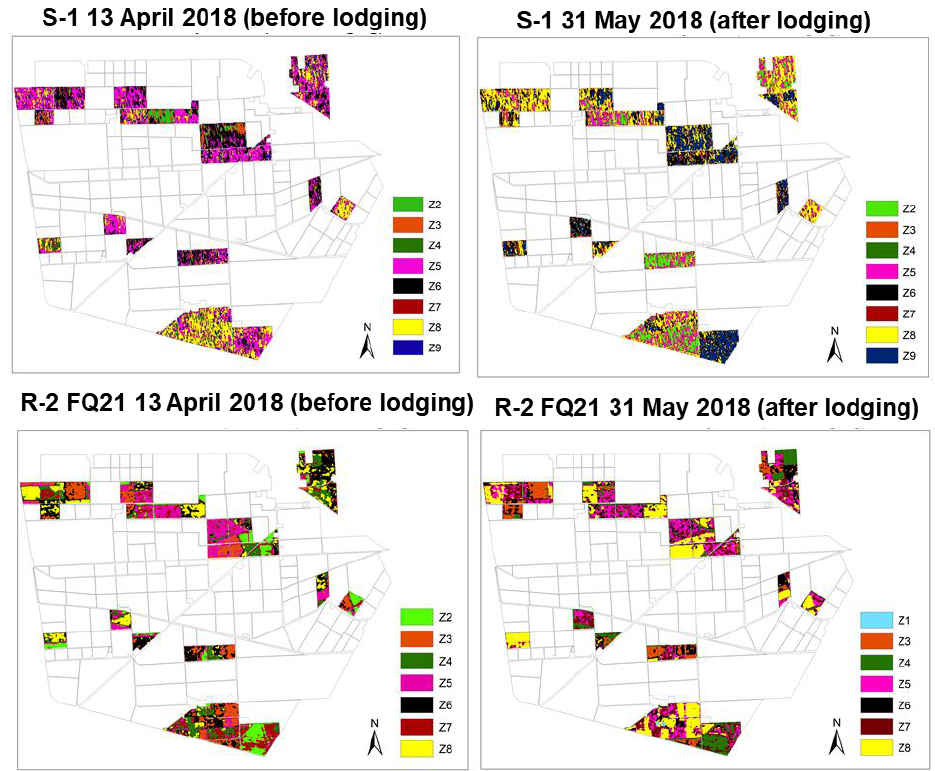
Figure 6. Combined H/α and Wishart unsupervised classification of scattering mechanisms from before and after lodging image pairs derived using same date Sentinel-1 (13 April, 31 May) and high incidence angle RADARSAT-2 FQ21 (13 April, 31 May) data, “RADARSAT-2 Data and Products. MacDonald, Dettwiler and Associates Ltd. (2018) – All Rights Reserved. RADARSAT is an official trademark of the Canadian Space